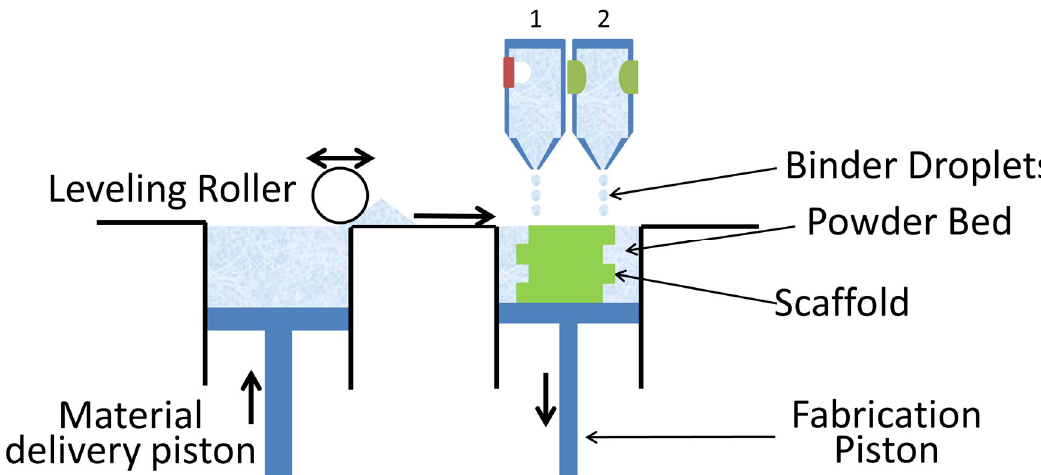
Figure 5. Schematic of Two Different Inkjet Printing Mechanisms over a powder bed: 1. Thermal-based, 2. Piezoelectric-based. The inkjet printheads dispense a binding solution to the powder bed below. The powder bed is lowered in height and a fresh layer of powder is positioned on top via a leveling roller. The process is then repeated.